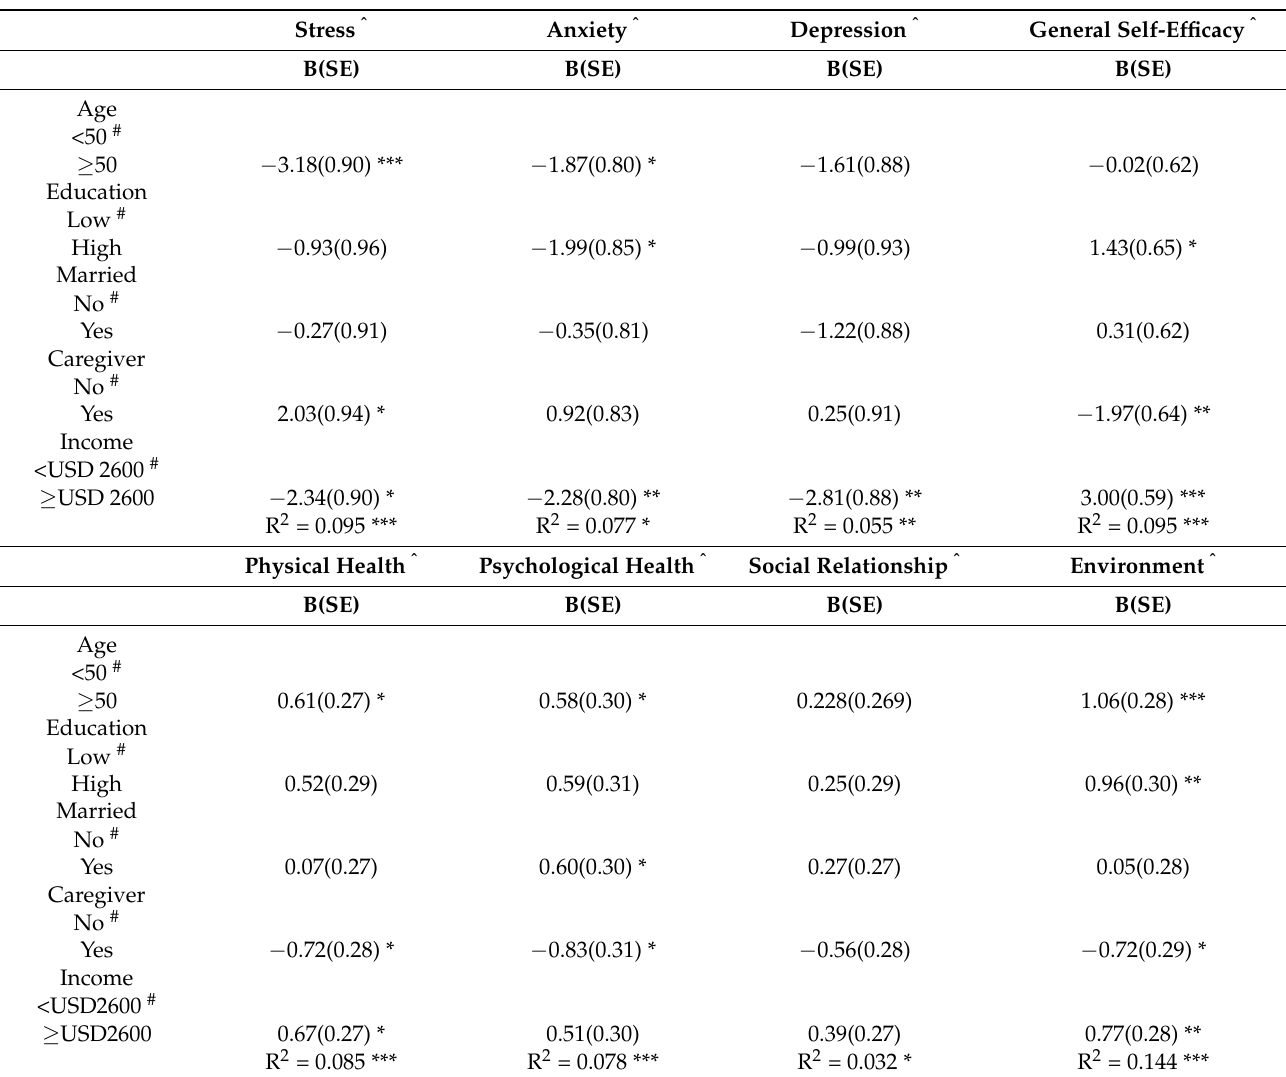
Table 5. Multivariable regression models of emotional states, general self-efficacy and the four domains of quality of